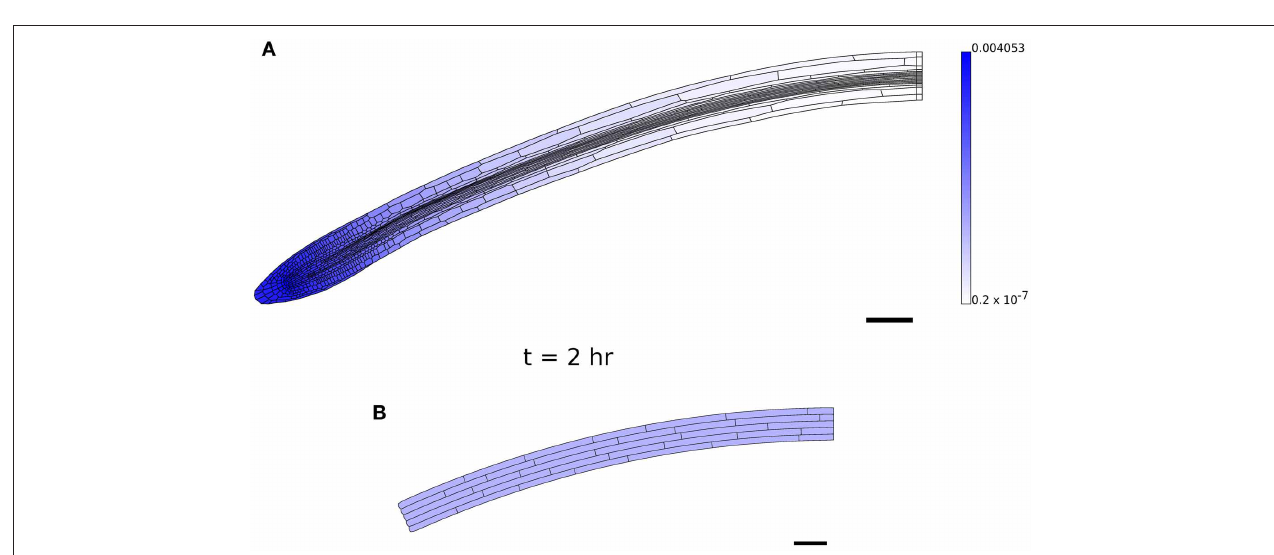
FIGURE 8 | Simulation of a growing Arabidopsis root apex. (B,C) Simulation results at t = 1hr and t = 2hr with initial geometry (A) . Shading indicates cell growth inhibitor concentration (on a logarithmic scale); graphs below ( B,C ) show the expansion rate of the cells (hr − 1 ), plotted at the x -position of the cell centroids. (D,E) The regions highlighted